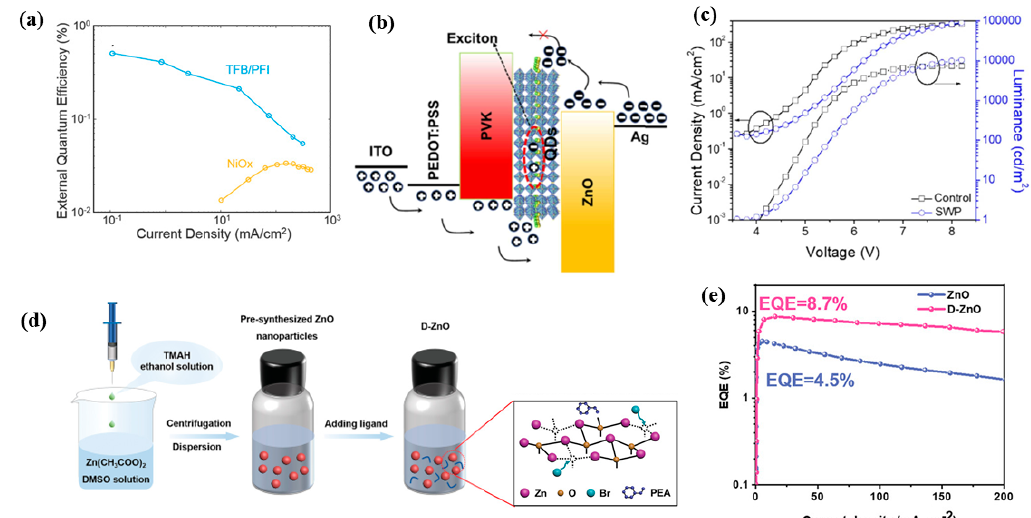
Figure 7. ( a ) EQE curves for LEDs fabricated using 469 nm perovskite nanocrystals and either NiO x (orange) or TFB/PFI (blue) as the HTL. Reproduced with permission from Ref. [23]. Copyright Wiley, 2018. ( b ) The energy level alignment with the proposed emission mechanism for the PeLEDs based on SWP QDs films; ( c ) current density and luminance of the PeLEDs versus bias. Reproduced with permission from Ref. [45]. Copyright Elsevier, 2022. ( d ) Schematic synthesis diagram of the D–ZnO colloidal nanocrystal solution; ( e ) the EQE of the champion PeLEDs based on ZnO and D–ZnO ETL. Reproduced with permission from Ref. [49]. Copyright Wiley, 2022.